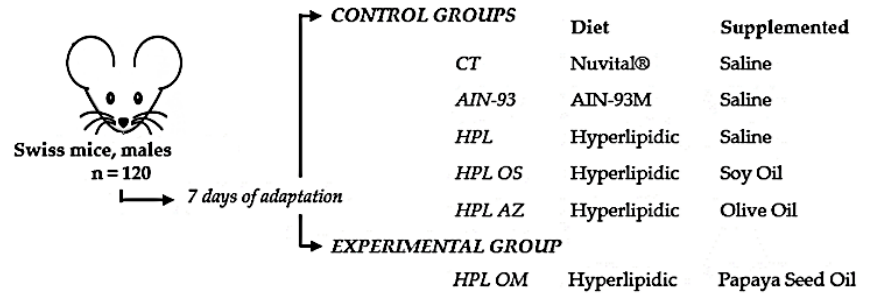
Figure 8. Experimental model design using a high-fat diet .